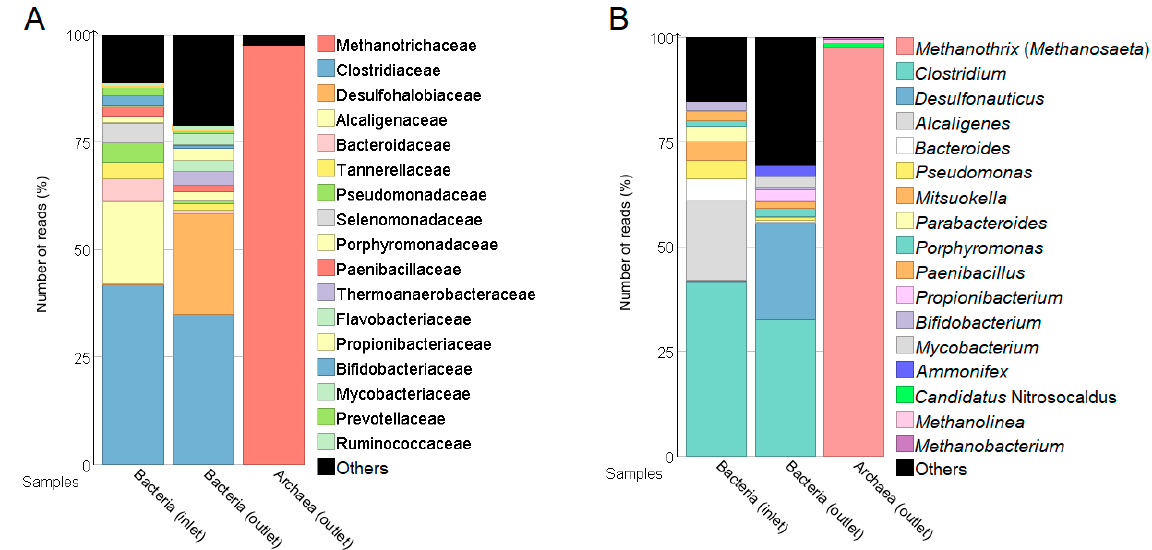
Figure 9. Abundance of bacterial and archaeal taxa at ( A ) family, and ( B ) genus taxonomic level in inlet and outlet samples.